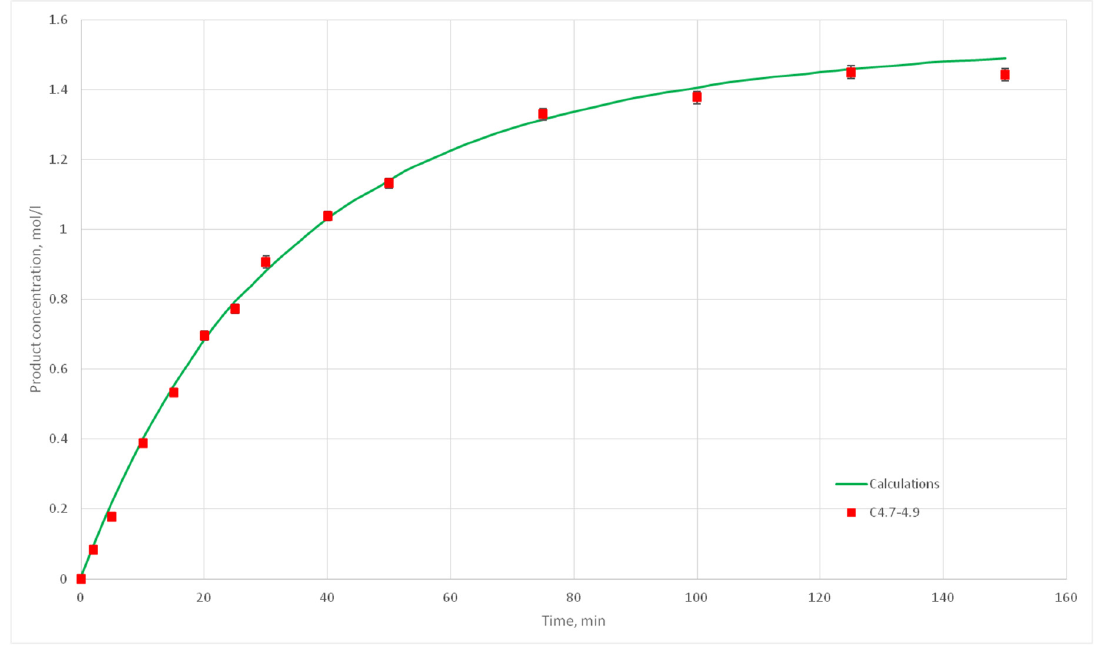
Figure 25. Calculation and experimental reaction kinetic curves for С 4.7, 4.8 и 4.9 experiments.